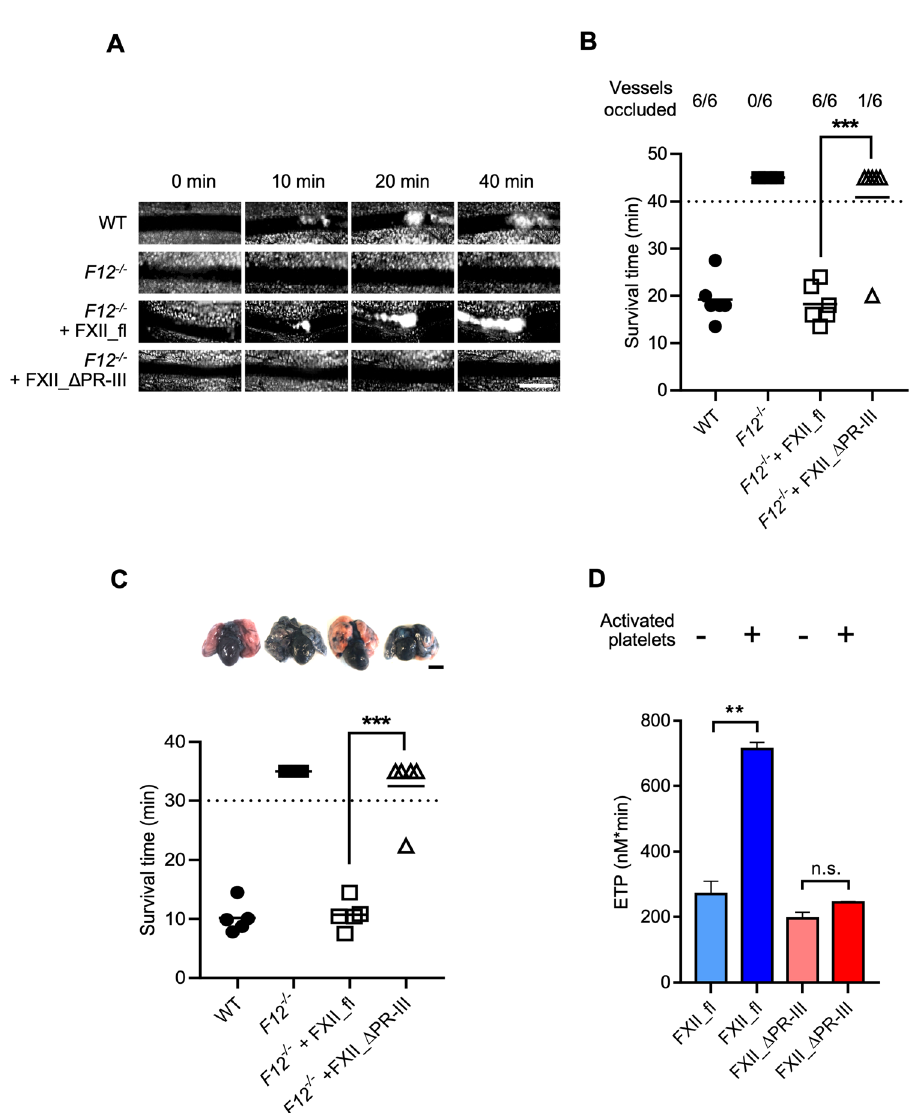
Fig. 5 Defective thrombosis in FXII_ Δ PR-III reconstituted F12 − / − mice. A Thrombus formation in vivo was monitored by intravital microscopy of mesenteric arterioles following topical application of 20% FeCl 3 in wild type (WT, top lane) and F12 – / – mice, reconstituted with buffer (second lane), FXII_ fl (third lane) or FXII_ Δ PR-III (bottom lane). Representative images of n = 6 experiments. Scale bar equals 50 µ m. B Time to complete occlusion after injury. Each symbol represents one monitored arteriole. The number of occluded vessels during the 40 min observation period is given at the top. n = 6 mice. C Pulmonary embolism induced by intravenous infusion of collagen/epinephrine. The survival time of WT, F12 − / − or F12 − / − mice with hydrodynamic tail vein injection-mediated transgene expression of FXII_ fl or FXII_ Δ PR-III was monitored. Mortality was assessed in each group of mice and animals alive 30 min after the challenge, were considered survivors; Top panel: Collagen/epinephrine-challenged mice were intravenously infused with Evans blue shortly after the onset of respiratory arrest and while the heart was still beating or for survivors, at 30 min post-challenge. Lungs were harvested and perfusion was determined. Occluded lung parts remain their natural pinkish colour. The bar represents 5 mm. n = 5 mice. In B , C : ***: P < 0.001, by unpaired two-tailed Student´s t test. Each symbol represents one animal. D ETP triggered by activated platelets (25 μ M ionomycin, 5 × 10 7 platelets/mL) or buffer in FXII_ fl or FXII_ Δ PR-III reconstituted FXII-de fi cient plasma. n = 4 PRP samples. n.s.: non-signi fi cant ( P > 0.05), **: P = 0.005, by unpaired two-tailed Student ’ s t test. Columns give means ±